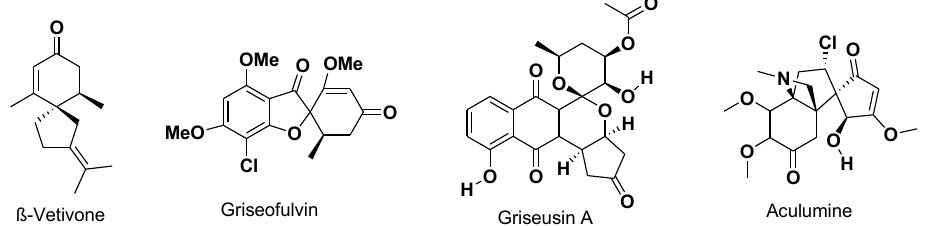
Figure 1. Selected examples of natural products and compounds of pharmaceutical interest which contain spiro rings.